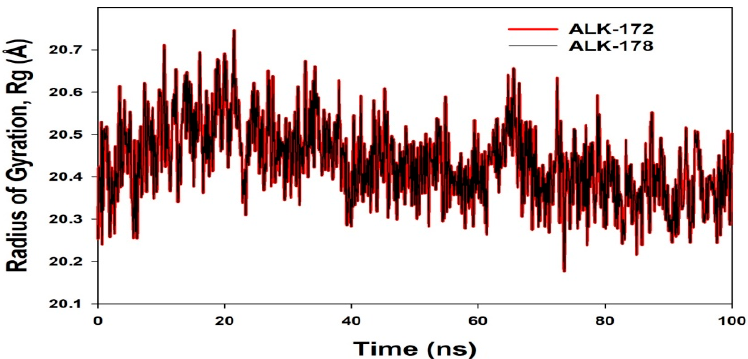
Figure 13. MD simulation trajectory analysis of Radius of gyration (Rg) of 172 and 178 bound with ALK at 100 ns time frame displayed H-Bond plot of 172 bound ALK (red), 178 bound ALK (black).